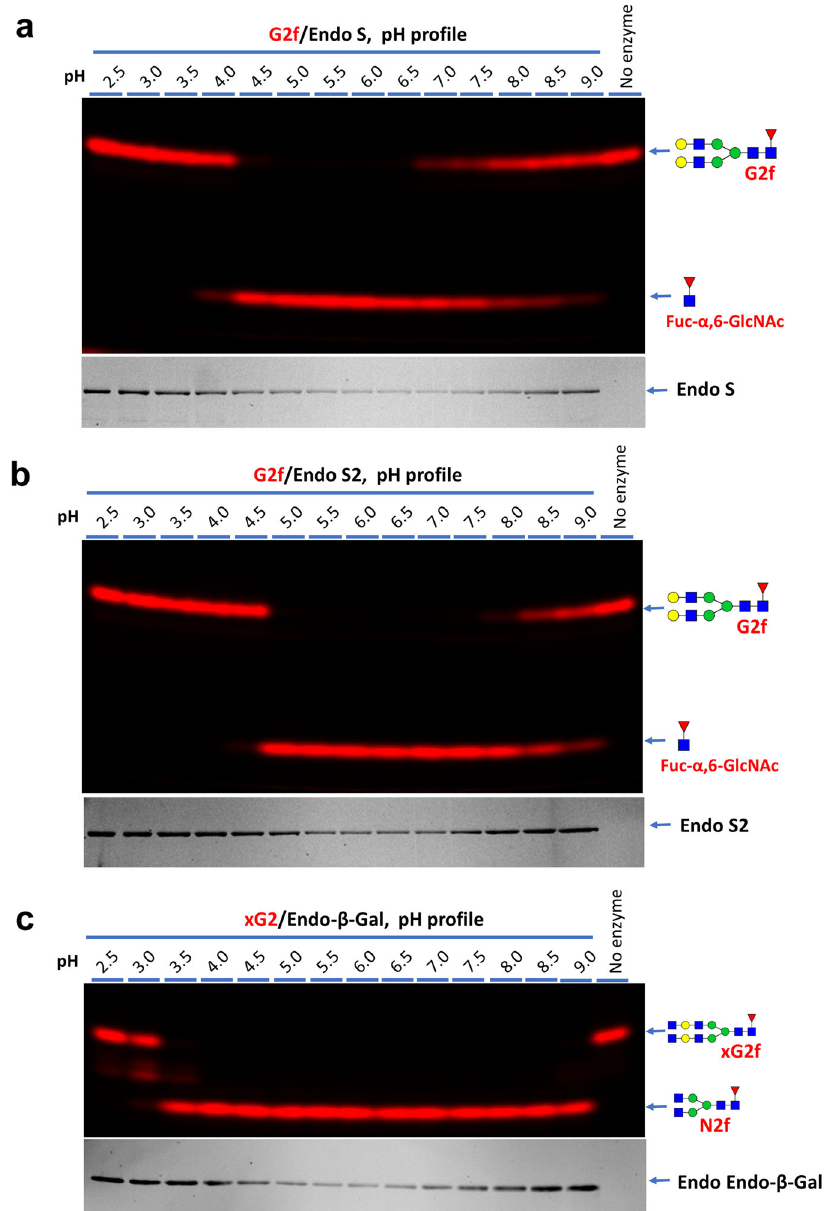
Fig. 4 pH pro fi les of the three endoglycosidases. In each reaction, 2 pmol of a substrate glycan was digested with 500 ng enzyme in 20 μ l buffer of indicated pH for 30 min at 37 °C and then separated on 15% gel. Both glycan images and protein images are shown for the assays. a pH pro fi le of Endo S on G2f. b pH pro fi le of Endo S2 on G2f. c pH pro fi le of Endo- β -Gal on